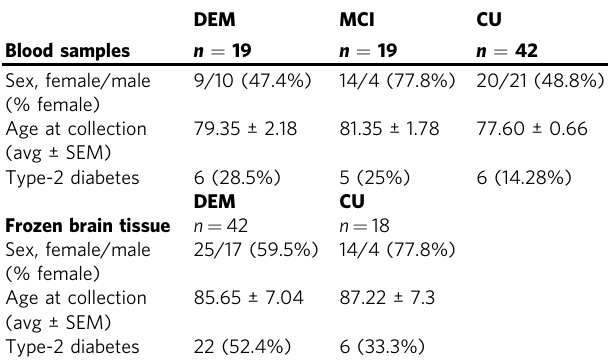
Table 1 Summary statistics for age, sex and type-2 DM status in individuals included in the cross-sectional analyses of: 1, amylin in blood and circulating monocytes; and 2, brain amylin and A β 42 concentrations by using